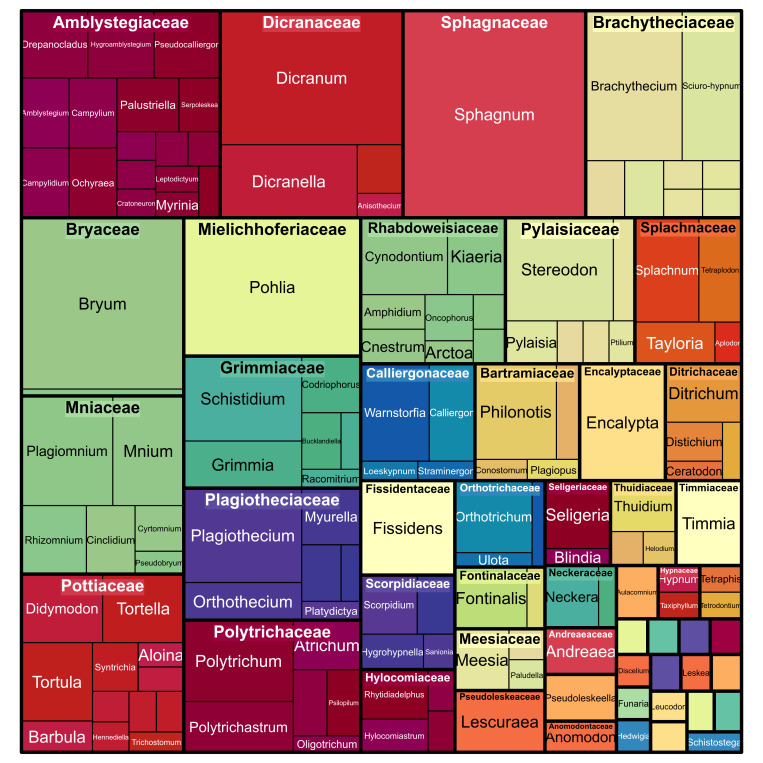
Taxonomic diversity of moss families in the dataset. The figure was prepared with the “treemap” package in R (Tennekes 2017).